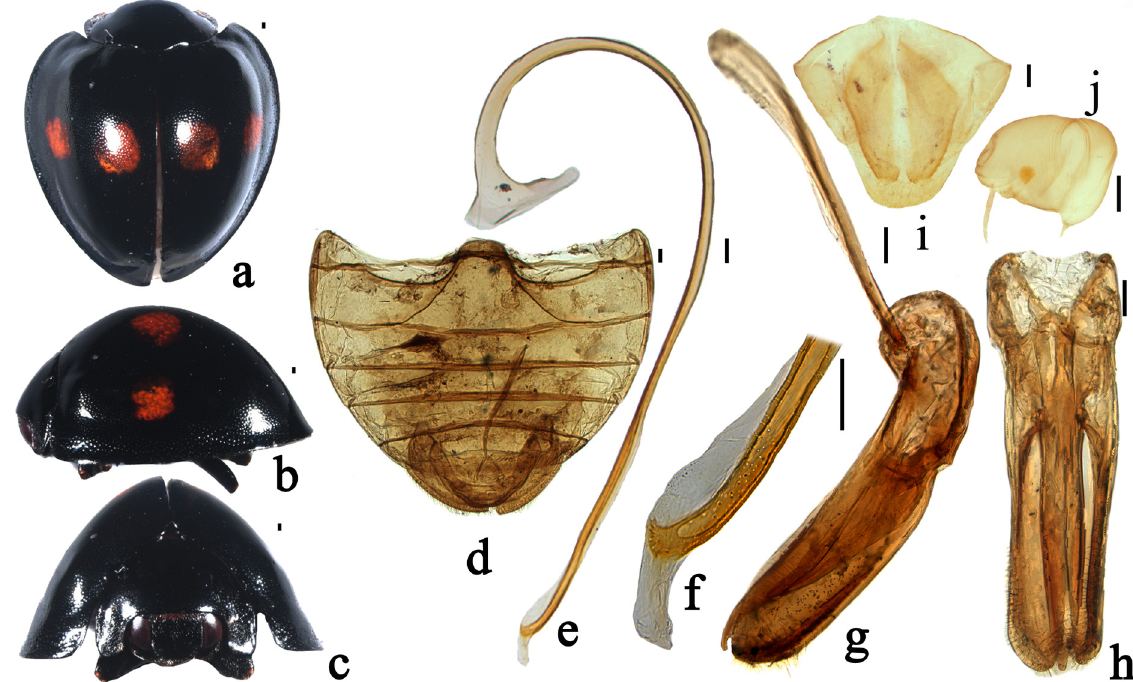
Fig. 18. Chilocorus bijugus Mulsant, 1853. a . Dorsal view. b . Lateral view. c . Frontal view. d . Abdomen. e . Penis. f . Apex of penis. g . Tegmen, lateral view. h . Tegmen, ventral view. i–j . Female genitalia. i . Ovipositor. j . Spermatheca. Scale bars: 0.1